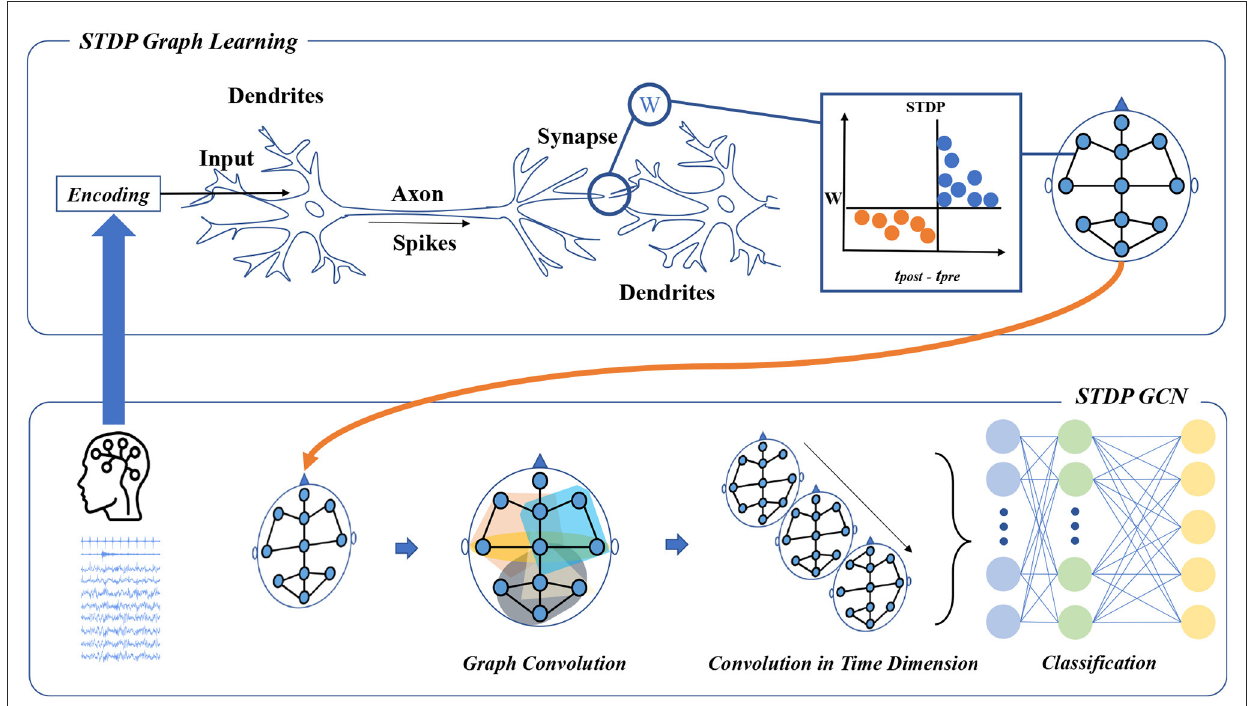
FIGURE1 The framework of STDP-GCN. The STDP graph learning approach views each channel in the PSG as a neuron, with the STDP mechanism determining the strength of connections between neurons to form a graph structure across the PSG channels. The graph structure is then used for graph convolution, followed by temporal convolution to learn the sleep stage transition rules, and a fully connected neural network is applied for classification.